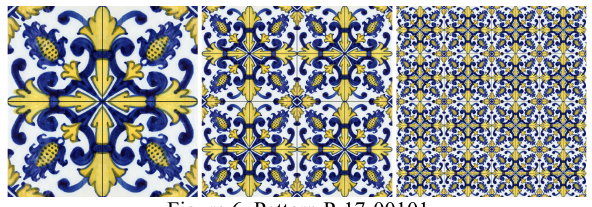
Figure 6. Pattern P-17-00101 Photo by Az Infinitum / Inês Aguiar